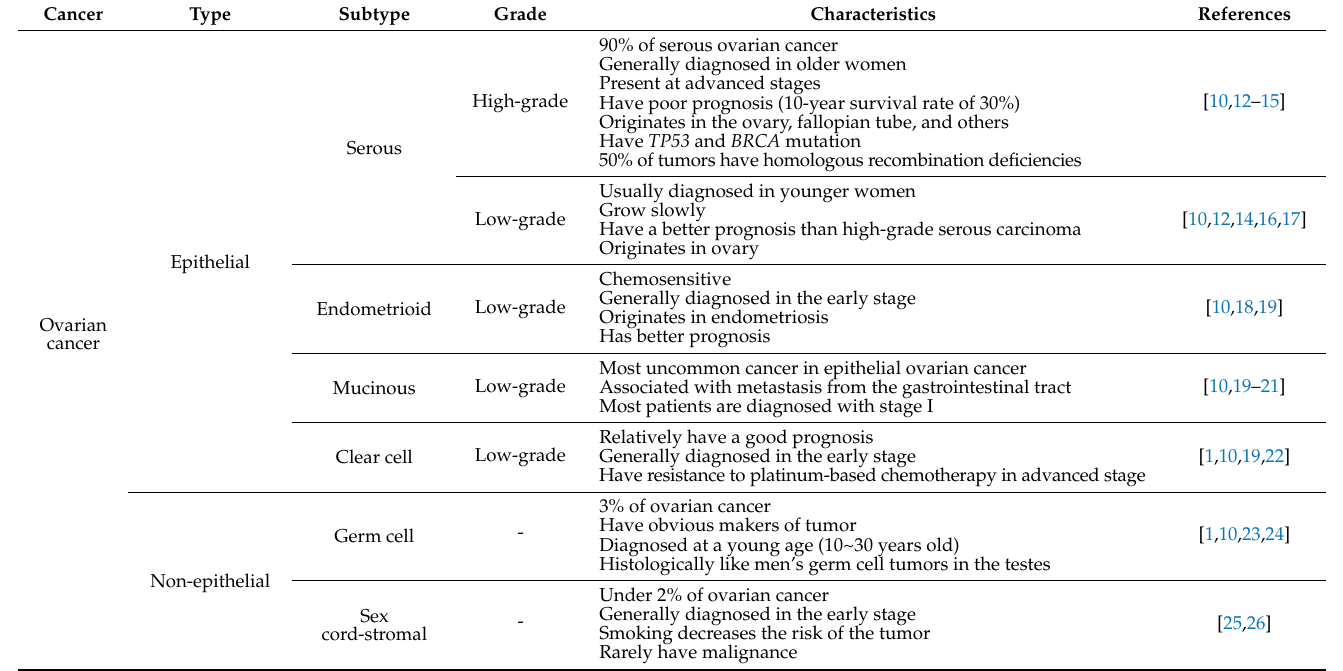
Table 1. Subtypes of ovarian cancer and characteristics of